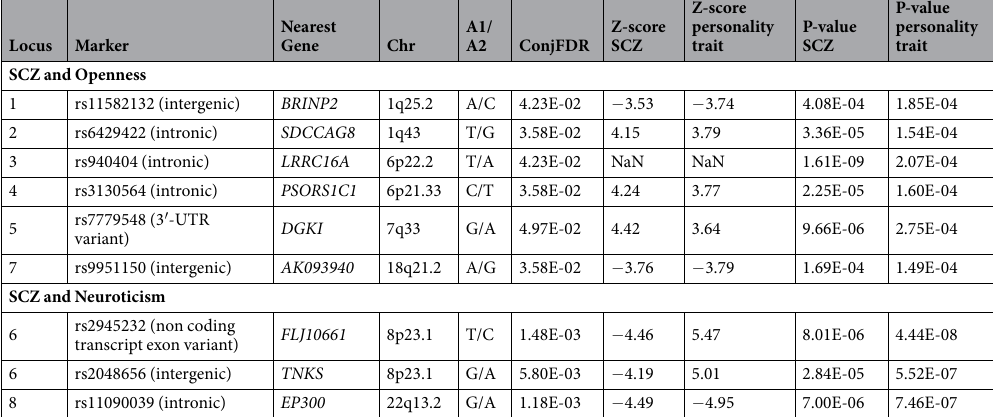
Table 1. Shared gene variants (conjFDR < 0.05) between SCZ and personality traits. Independent complex or single gene loci (r 2 < 0.1) with SNP(s) with a conjunction FDR (conjFDR) < 0.05 shared between SCZ and the Big Five personality traits. All significant SNPs are listed and sorted in each LD block and independent loci are listed consecutively (Locus #). All data were first corrected for genomic inflation. We also included agreeableness and conscientiousness in the conjFDR analysis, but there was no locus with conjFDR < 0.05 shared between either of these traits and SCZ. Abbreviations: Chr = chromosome, A1 = allele number one, A2 = allele number two, NaN = not a number; z-score not computable due to T-A polymorphism, SCZ = schizophrenia, FDR = false discovery